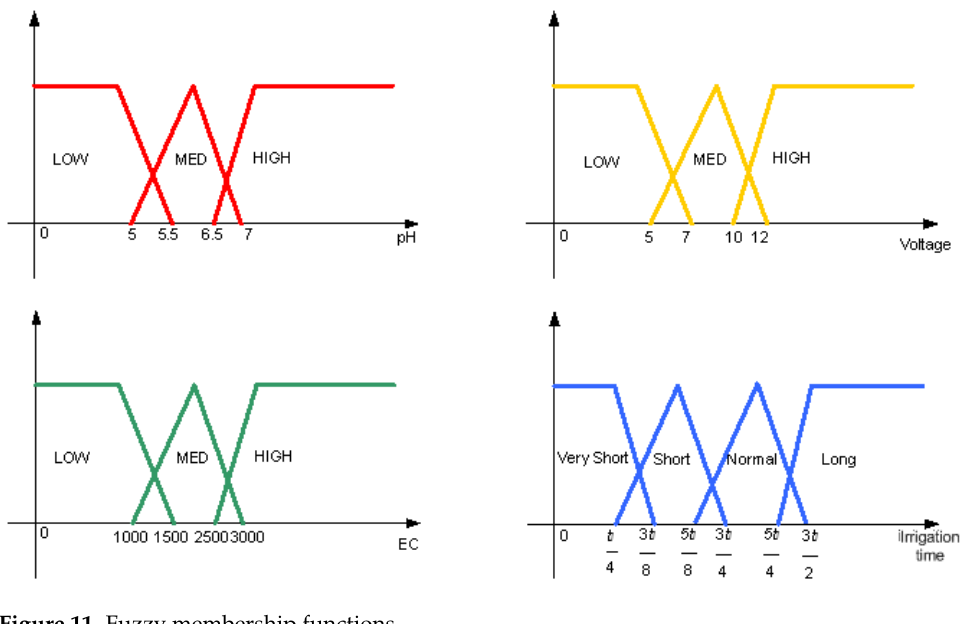
Figure 11. Fuzzy membership functions. Table 4. Fuzzy rule structure with